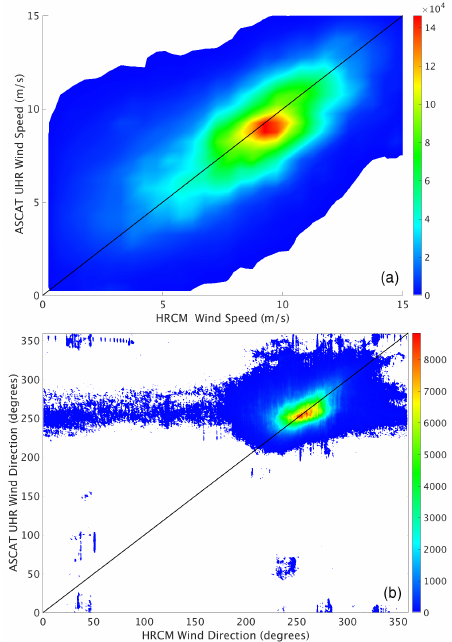
Figure 3. ASCAT UHR wind speeds ( a ) and directions ( b ) collocated with HRCM winds. A y = x line is included in each plot for